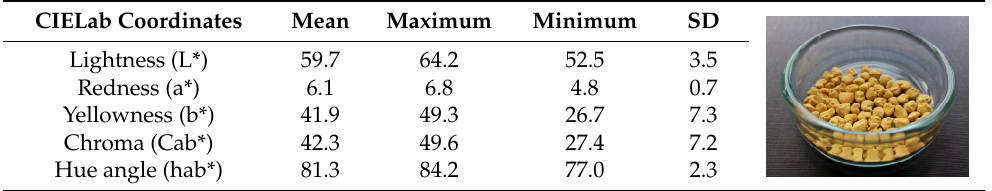
Table 2. Description of the color variables in the CIELab* scale.